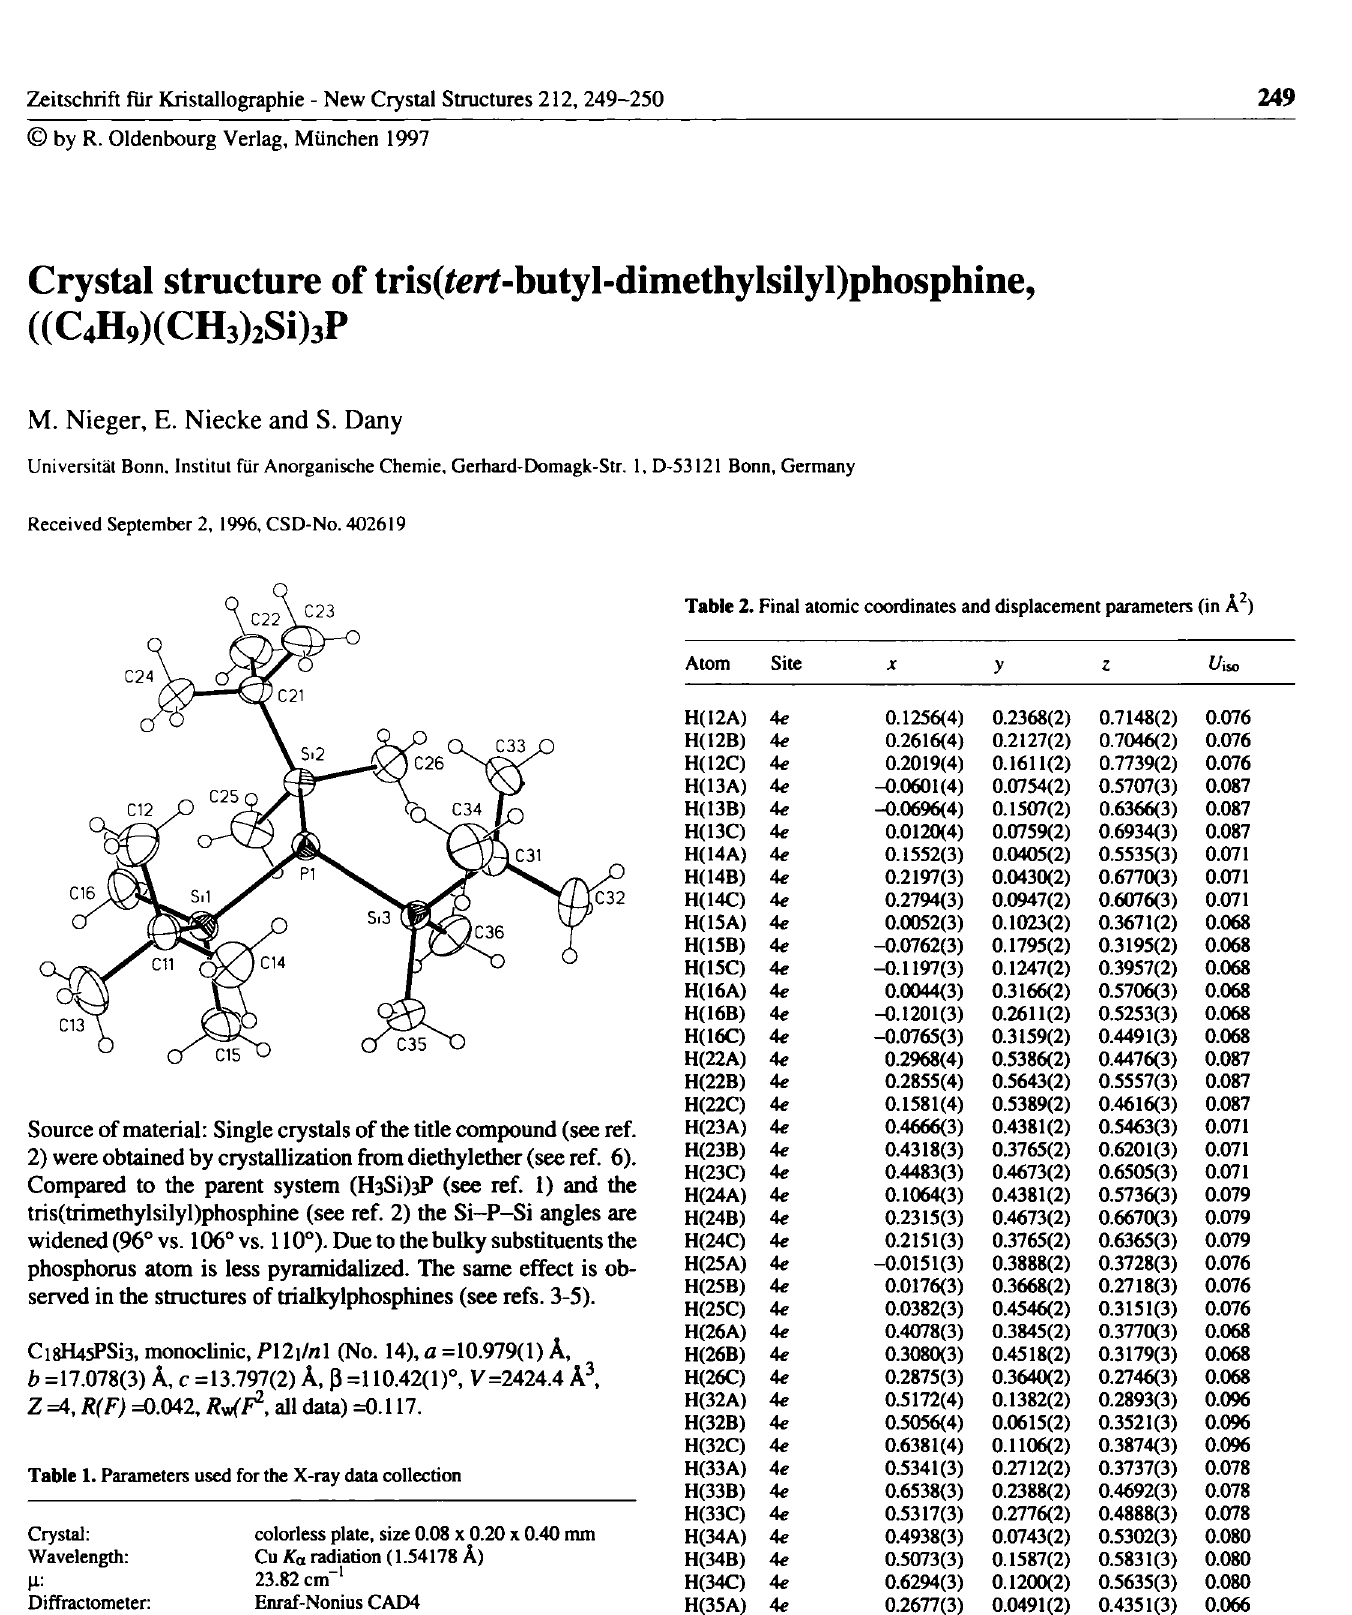
Table 1. Parameters used for the X-ray data collection